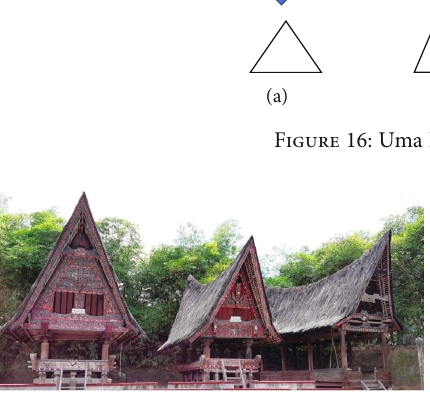
Figure 17: Batak Toba traditional houses